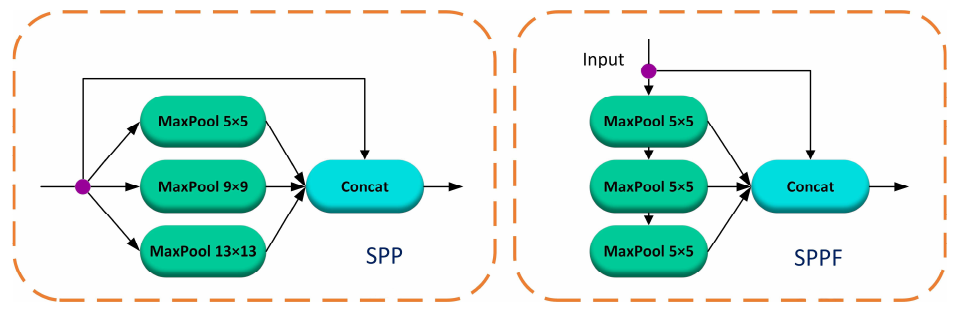
Figure 2. Structure of SPP and